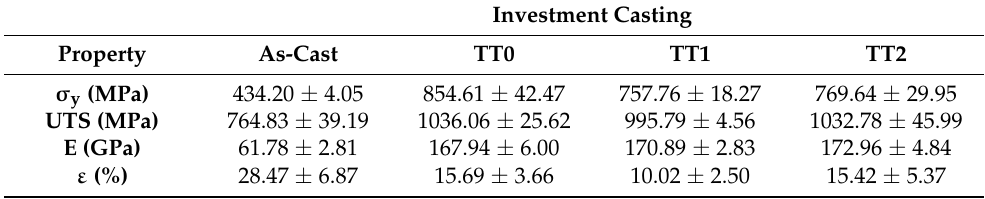
Table 6. Summary of mechanical properties for IN718 alloy obtained by investment